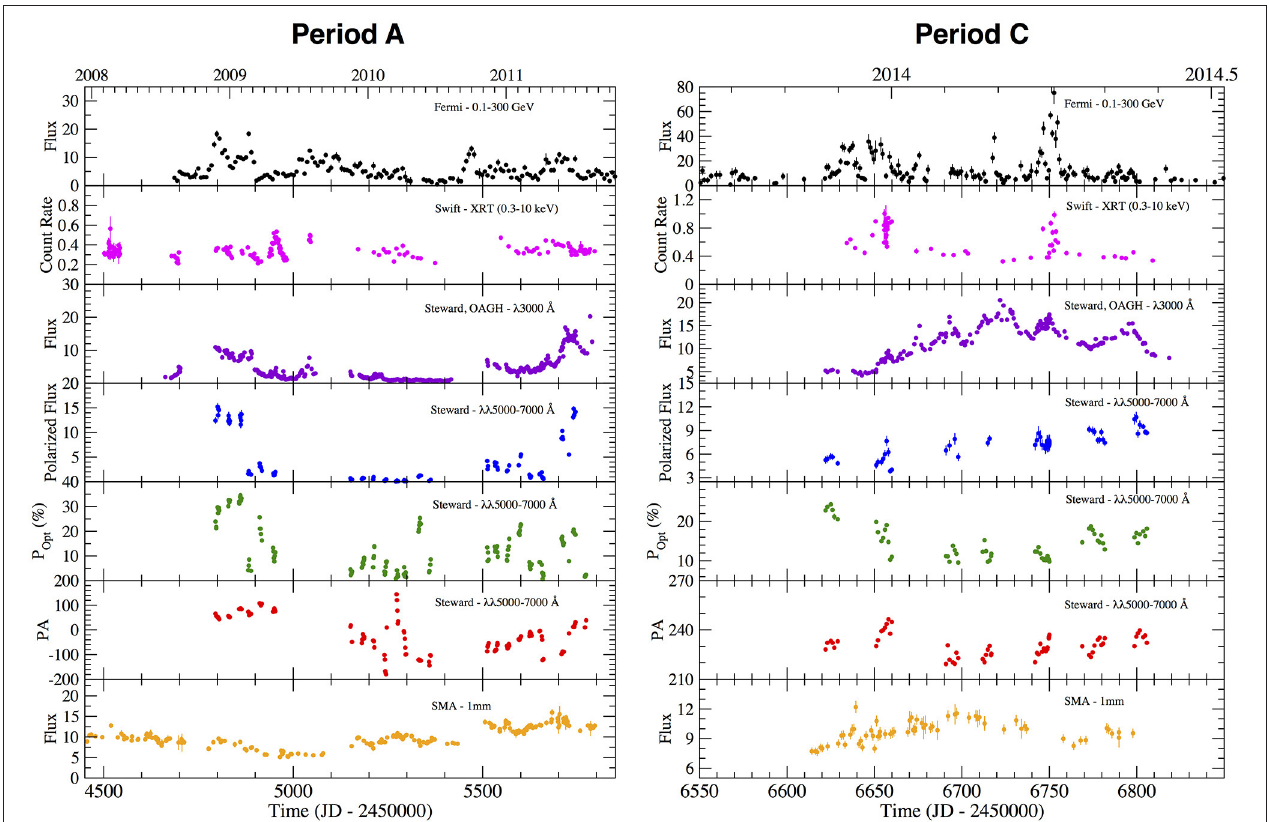
FIGURE 1 | Left: Light Curves for 3C 279 during Period A. Right: Light Curves for 3C 279 during Period C. These are the two different epochs where we found different delays between the UV continuum and the gamma-rays. This difference in the delay suggests a change in the dominant gamma-ray emission mechanism. From top to bottom, the vertical axes units are: [phcm − 2 s − 1 ], [c / s], [ × 10 − 15 ergcm − 2 s − 1 Å − 1 ], [ × 10 − 13 ergcm − 2 s − 1 ], [%], [degrees],